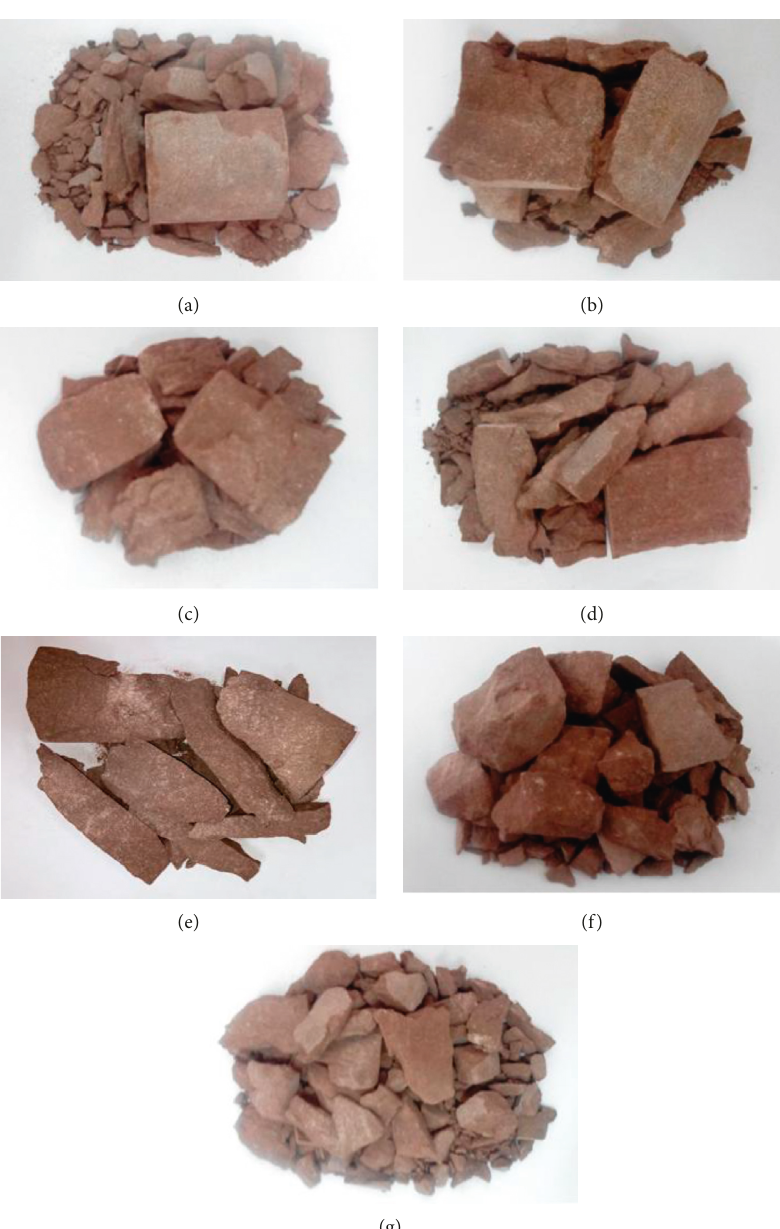
Figure 7: Sandstone failure morphology for different water contents. (a) ω � 0.00%. (b) ω � 2.01%. (c) ω � 2.23%. (d) ω � 2.40%. (e) ω � 2.49%. (f) ω � 2.53%. (g) ω �